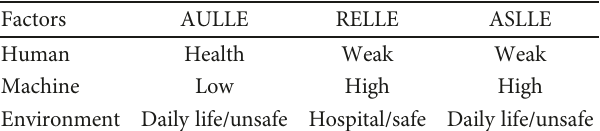
Figure 1: The prototype of AIDER with a SCI patient. Table 1: The in fl uence for three kinds of exoskeletons on the